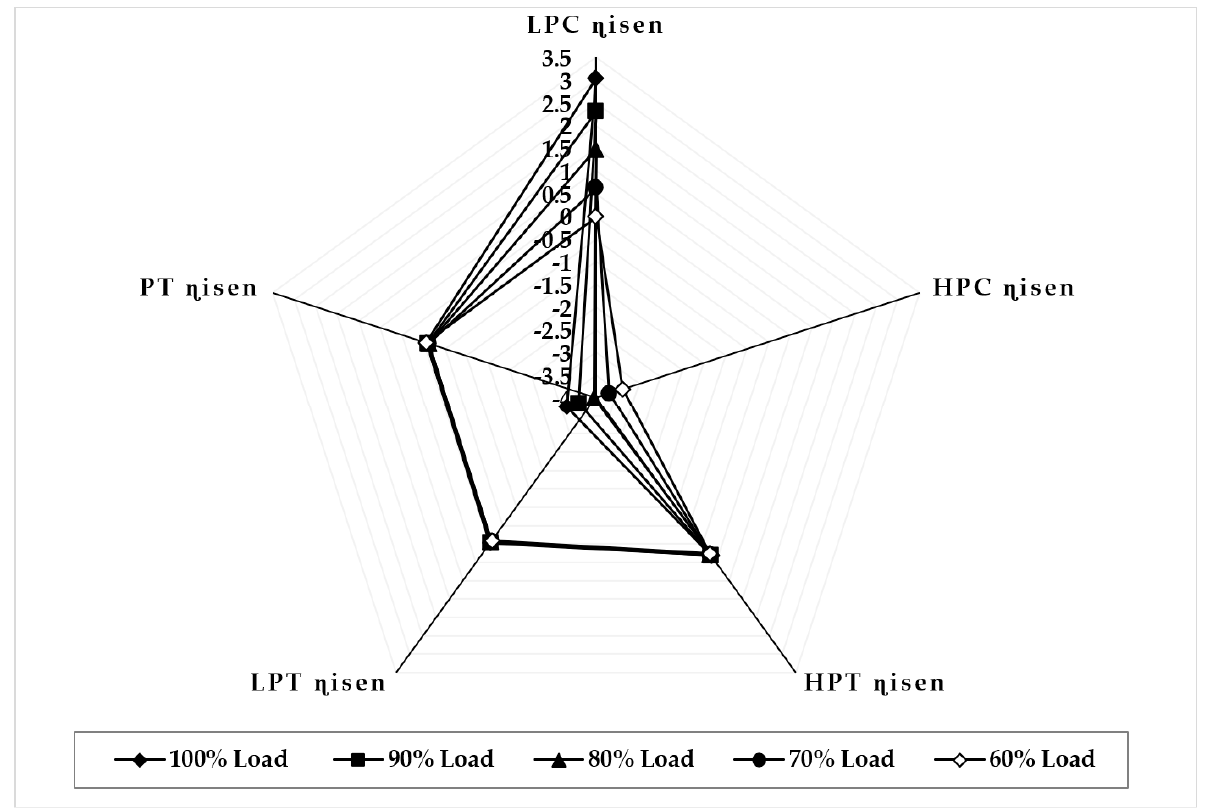
Figure 9. Deviation in component isentropic efficiency due to HPC fouling at 100% fault severity at full − load and part − load operation.